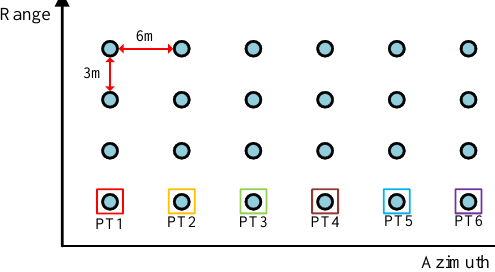
Figure 9. The ground scene for simulation.